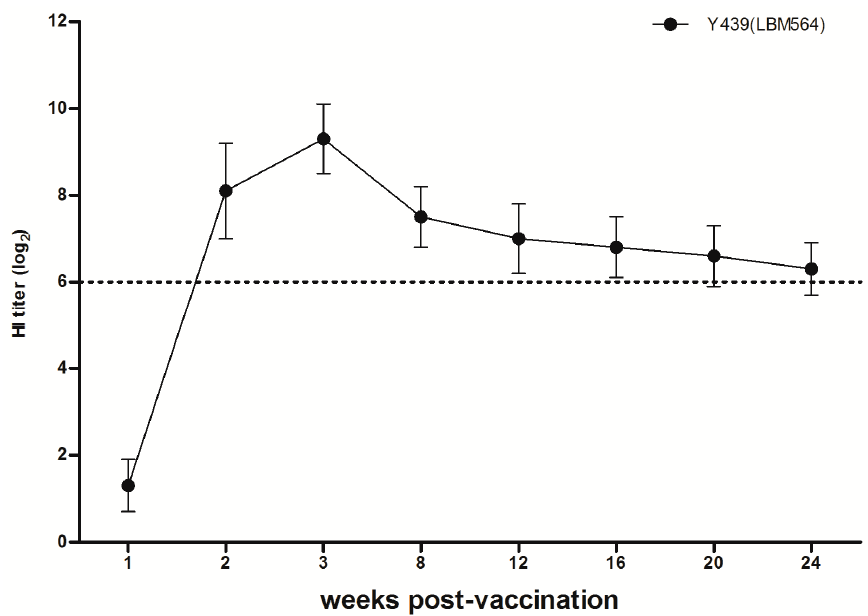
Figure 3. Antibody persistence after vaccination with vac564. Hemagglutination inhibition (HI) titers were examined up to 24 weeks post-vaccination (wpv). vac564 induced HI titers of >6 log 2 at 2–24 wpv. The horizontal dotted line indicates a HI titer of 6 log 2 , which is the criterion for H9N2 LPAI vaccine efficacy in the Republic of Korea.